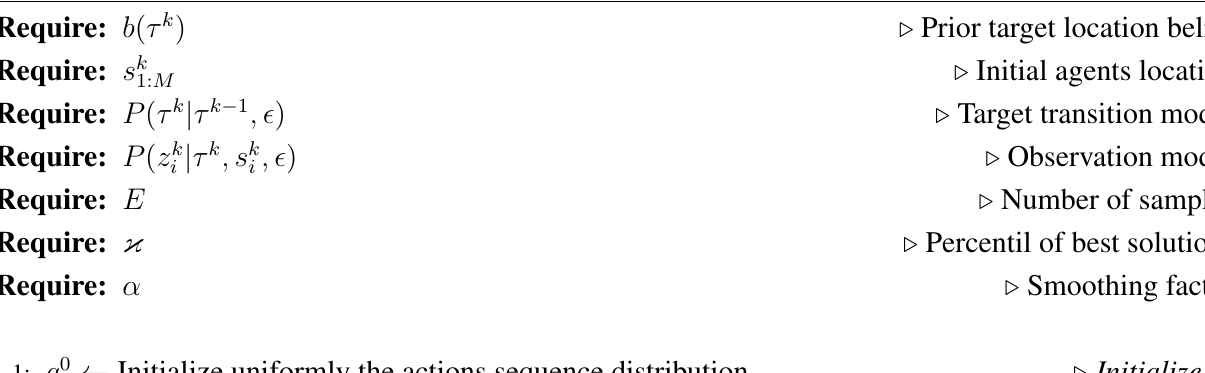
Algorithm 3 Cross Entropy Optimization